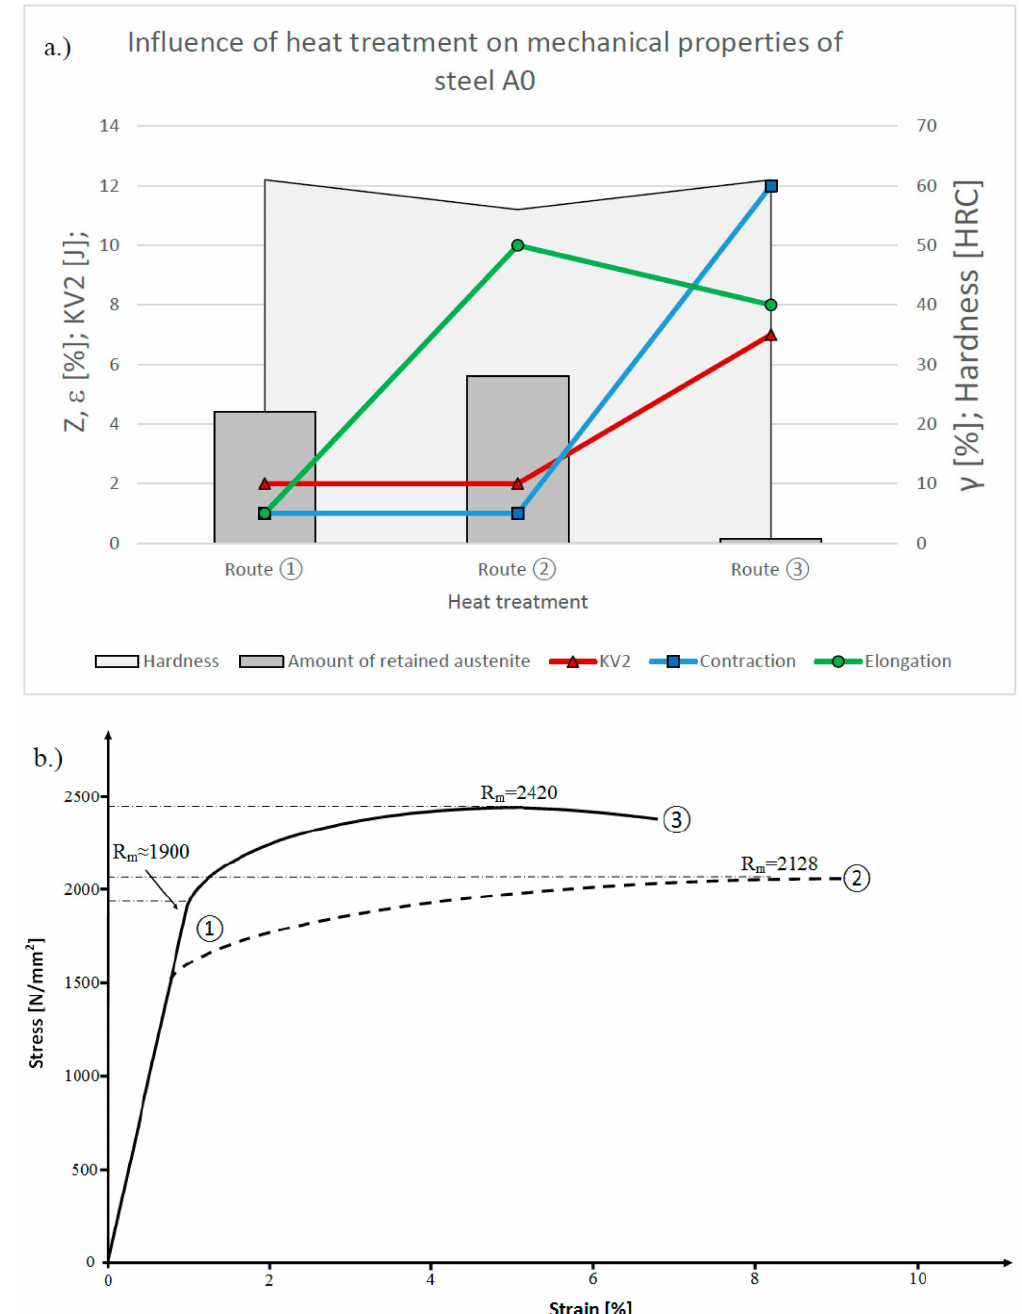
Figure 7. Balance of mechanical properties, of steel A0 in relation to heat treatment: ( a ) general overwiev, ( b ) corresponding tensile